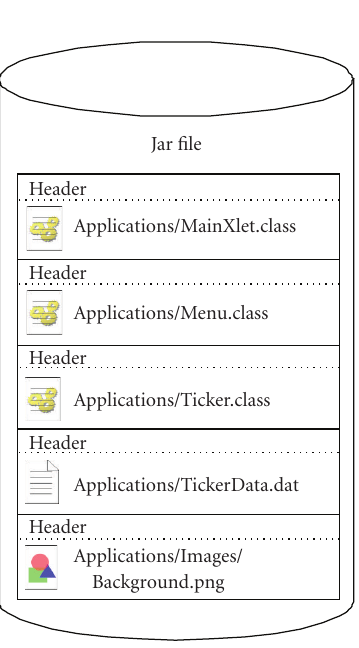
Figure 7: Interactive data format in Blu-ray.